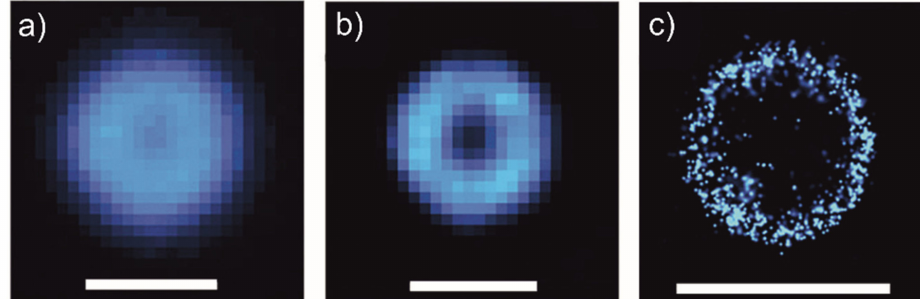
Figure 10. Microscopic analysis of protein adsorption onto 900 nm MSNs. ( a ) Wide-field, as acquired; ( b ) wide-field, deconvolved; ( c ) STORM. Scale bar = 1000 nm. Adapted with permission from [154], Copyright 2017 American Chemical